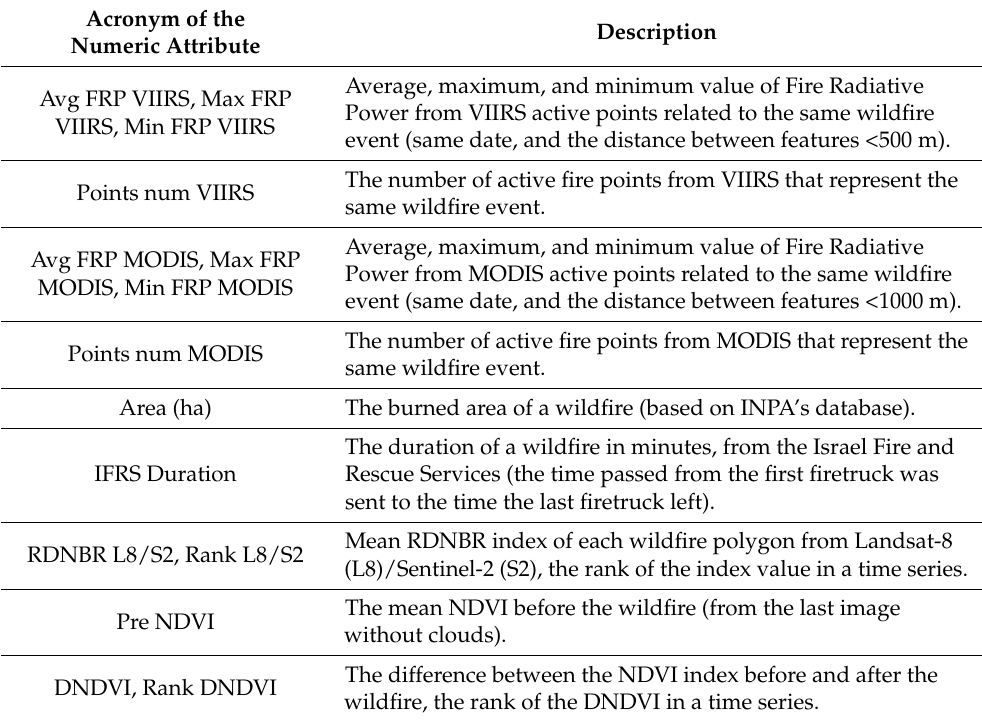
Table 1. Acronym table of the numeric attributes of the final database. Acronym of the Numeric Attribute